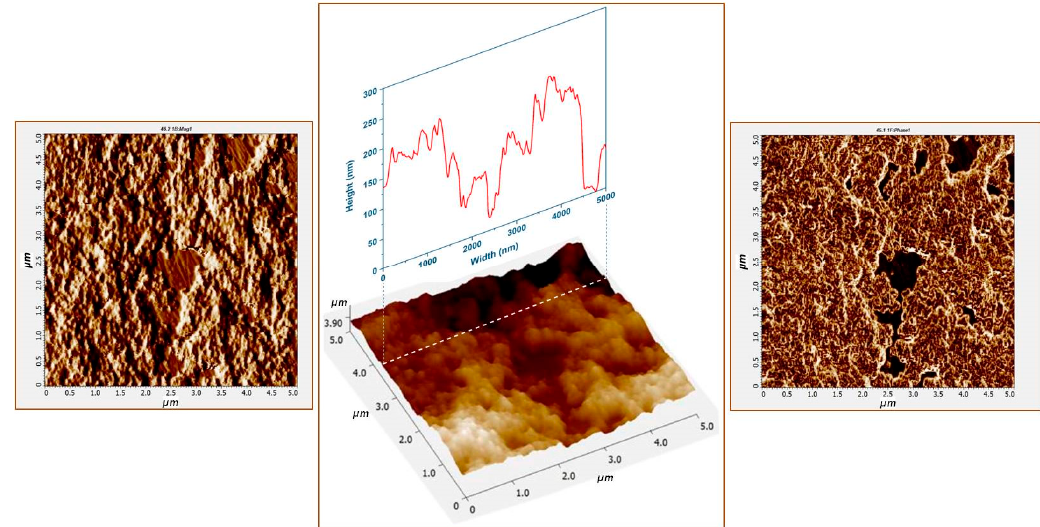
Figure 2. 5 × 5 µm 2 topographic images of the silver solid substrate acquired in magnitude mode (left) and height mode (center). The phase image of the same area is presented on the right image. A height profile is highlighted in the inset of the central image.